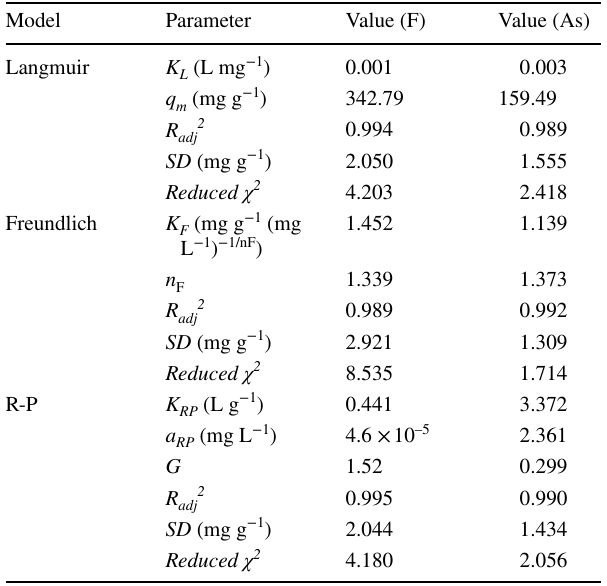
Table 6 Langmuir, Freundlich and R-P adsorption models constant as applied to Fluoride and arsenic adsorption on Fe-KWC Model